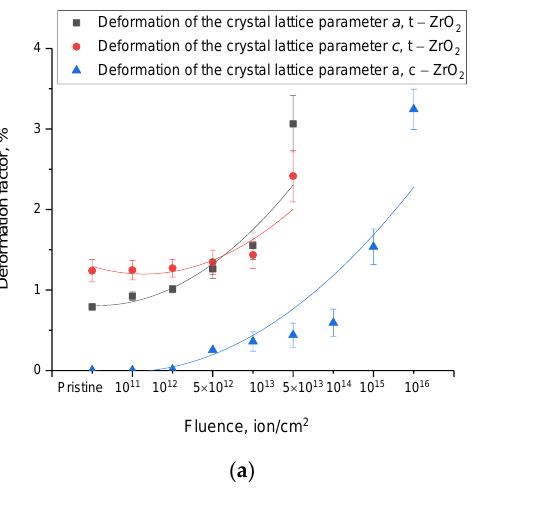
Figure 7. ( a ) Results of the change in the deformation factor of the crystal lattice parameters for the t-ZrO 2 and c-ZrO 2 phases, depending on the irradiation fluence; ( b ) Results of the change in the crystal lattice volume during the radiation damage accumulation.